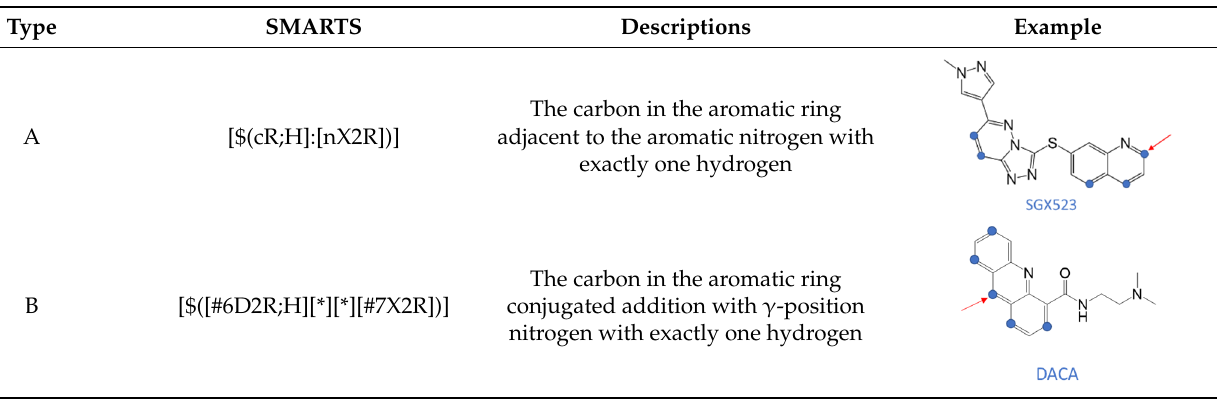
Table 1. Potential Sites of Metabolism by hAOX.